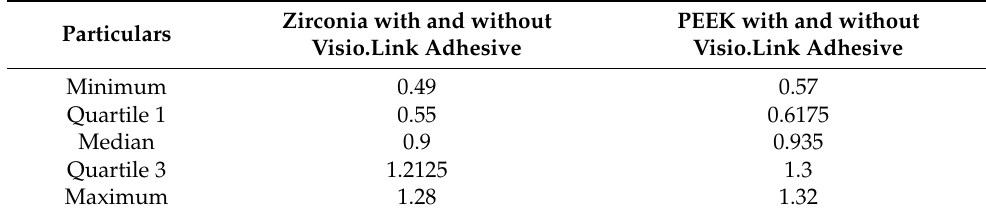
Figure 11. Comparison of mean tensile bond strength of poly ether ether ketone (PEEK) and Zirconia.Vertical Axis: 1—Zirconia with and without Visio.link adhesive, 2—PEEK with and without Visio.link adhesive. Table 4. Particulars of mean tensile bond strength of poly ether ether ketone (PEEK) and Zirconia.